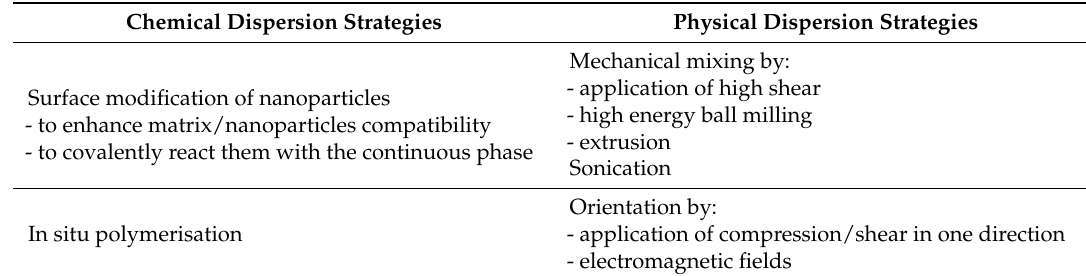
Table 1. Strategies for nanoparticles’